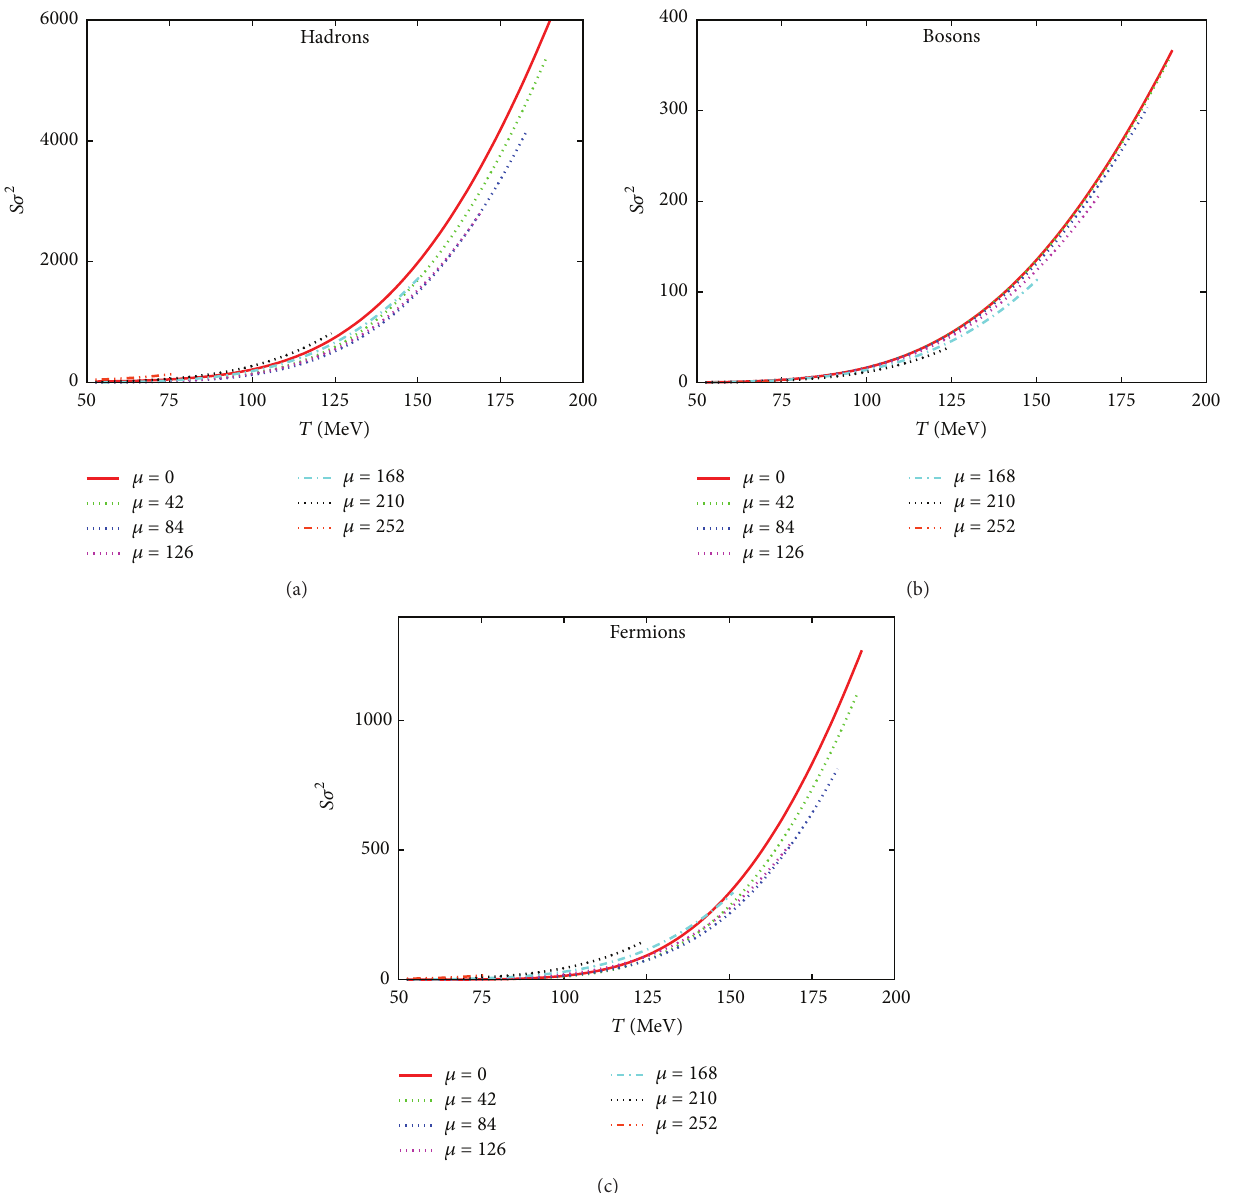
Figure 10: The thermal evolution of 𝑆𝜎 2 for hadrons (a), bosons (b), and fermions (c) at different 𝜇 -values (given in MeV).